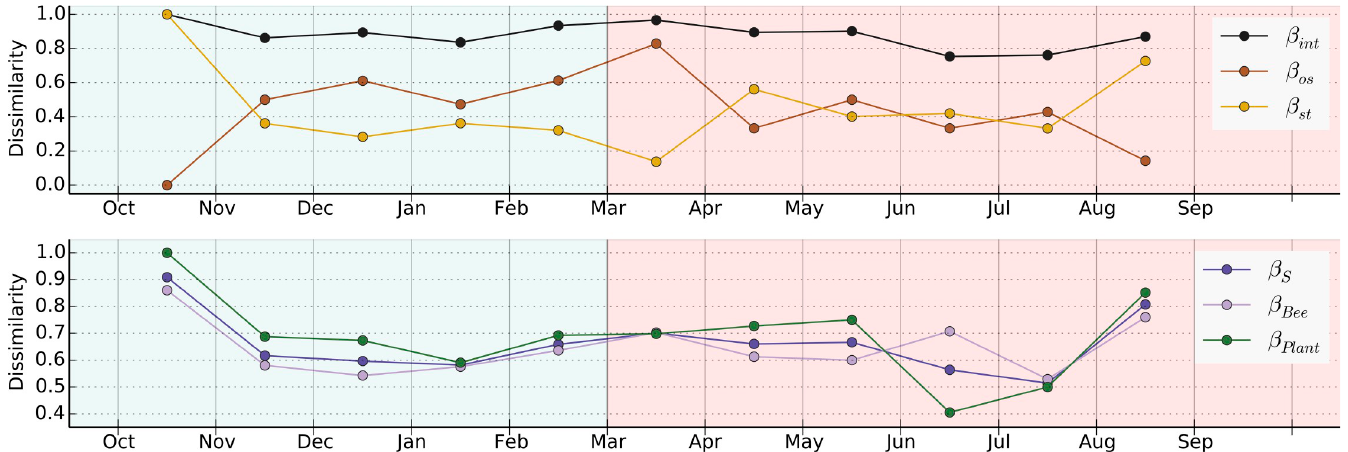
Fig 5. Correlation results for plant turnover ( β pl ) and interaction turnover ( β int ) rates in the studied community. A high β pl and/or β int value indicates a high dissimilarity between interactions and/or plant composition (r s : Spearman ’s rank correlation coefficient; p : p -values generated using Monte Carlo simulations.).